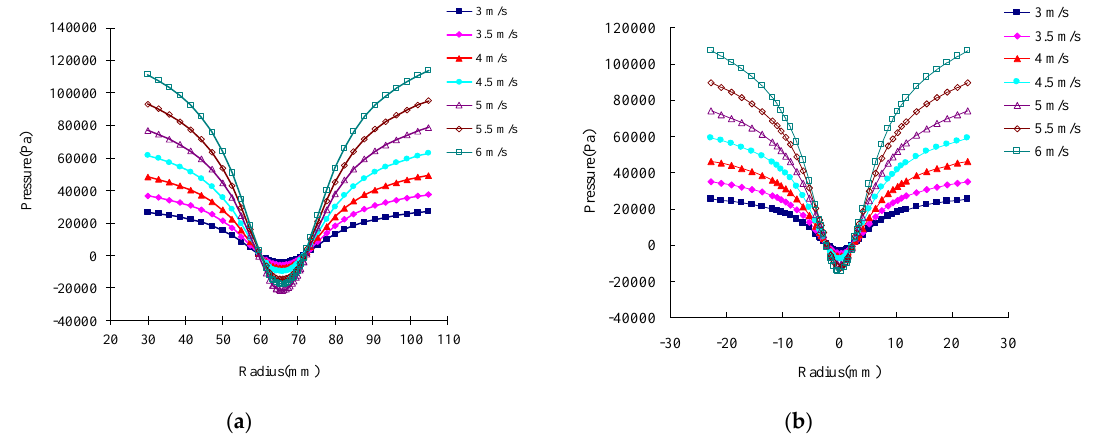
Figure 6. Radial pressure distributions: ( a ) Z = 300 mm (first stage); ( b ) Z = 150 mm (second stage). The radial pressure gradient force